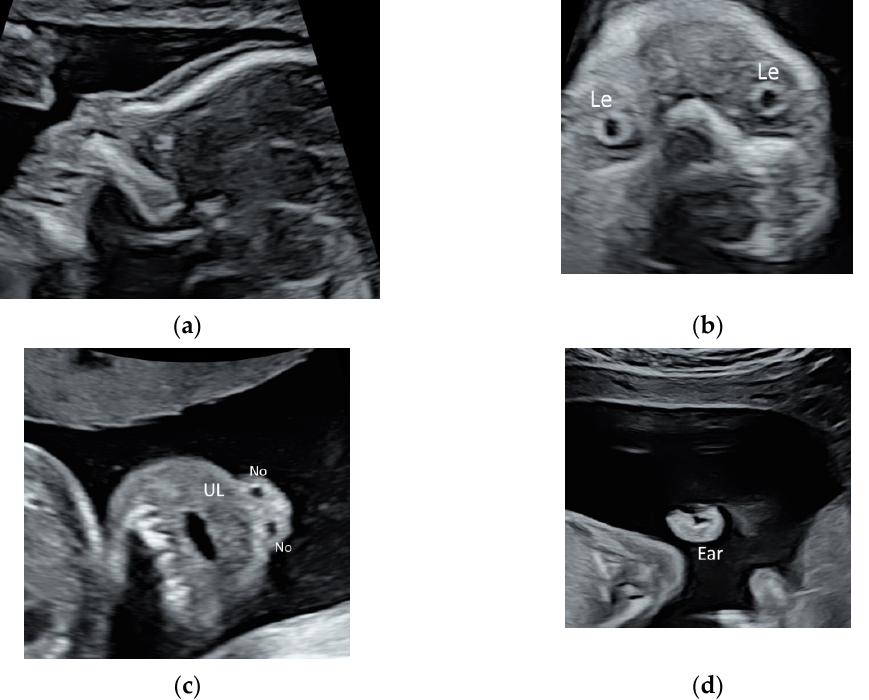
Figure 3. High-resolution ultrasonography of the fetal face at 20 weeks’ gestation: ( a ) mid-sagittal view showing facial profile, ( b ) coronal view showing both lens (Le), ( c ) coronal view showing the upper lip (UL) and two nostrils (No), and ( d ) sagittal view showing the ear. Larynx and its movement can be assessed by prenatal ultrasound (Figure 4 and Video S4). In at-risk fetuses such as those with laryngeal atresia [17] and congenital di- aphragmatic hernia, prenatal ultrasound allows systematic examination of the larynx, including vocal cords to detect laryngeal anomalies [17,18].